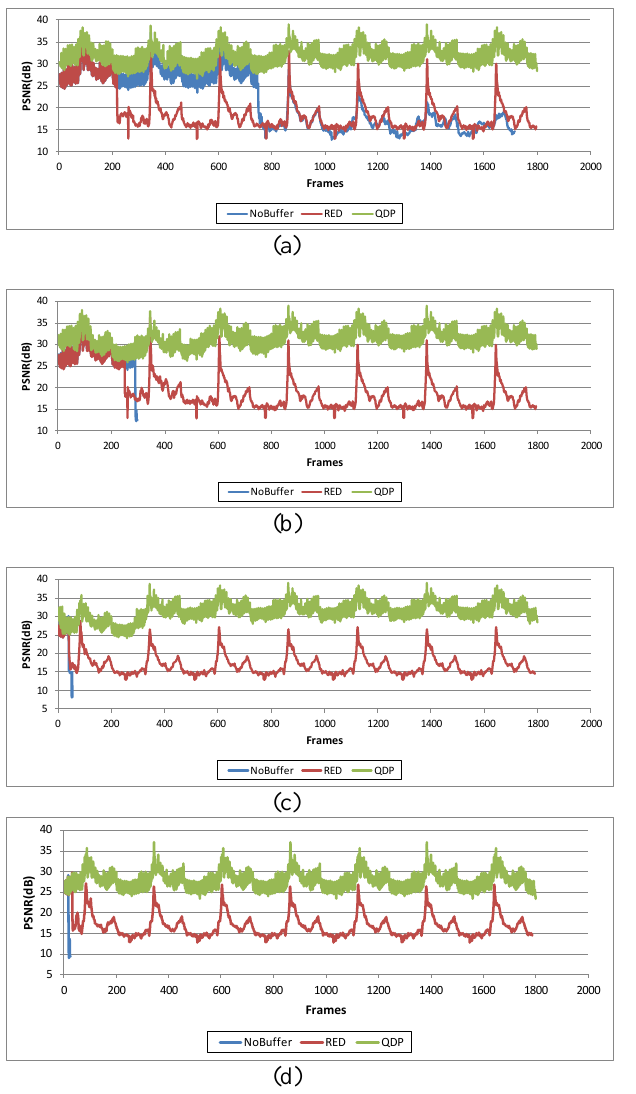
Figure 4. PSNR vs. Frames to different buffer sizes: (a) 1MB, (b) 500KB, (c) 100KB, (d) 50KB